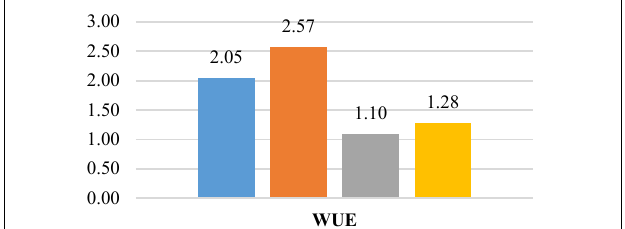
FIGURE 1 | WUE (kg m − 3 ) in B. carinata derived B. juncea lines (Parents) and their hybrids under rainfed (RF) and irrigated (IR) conditions.